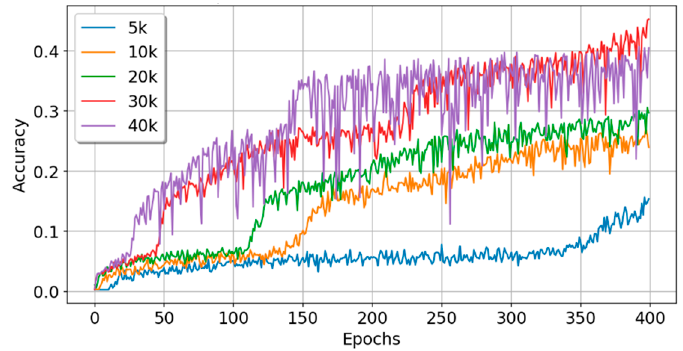
Figure 19. The performance of MLP for different size data.